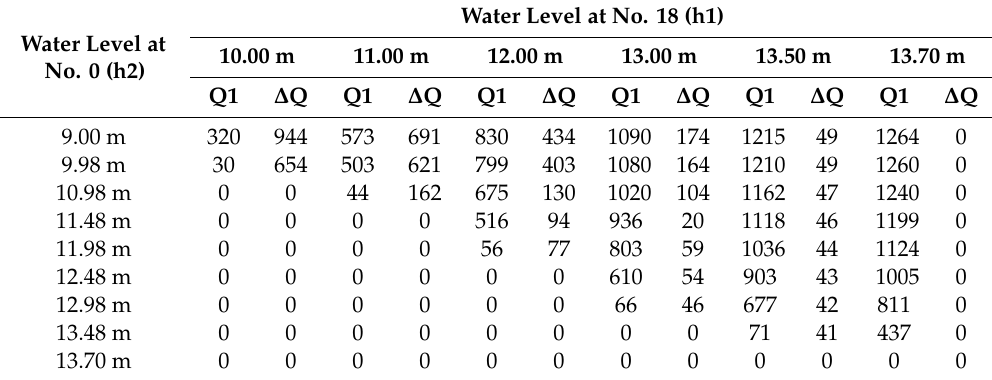
Table 5. Discharge conditions at point No. 18 for evacuation warning criteria (unit: m 3 / s).